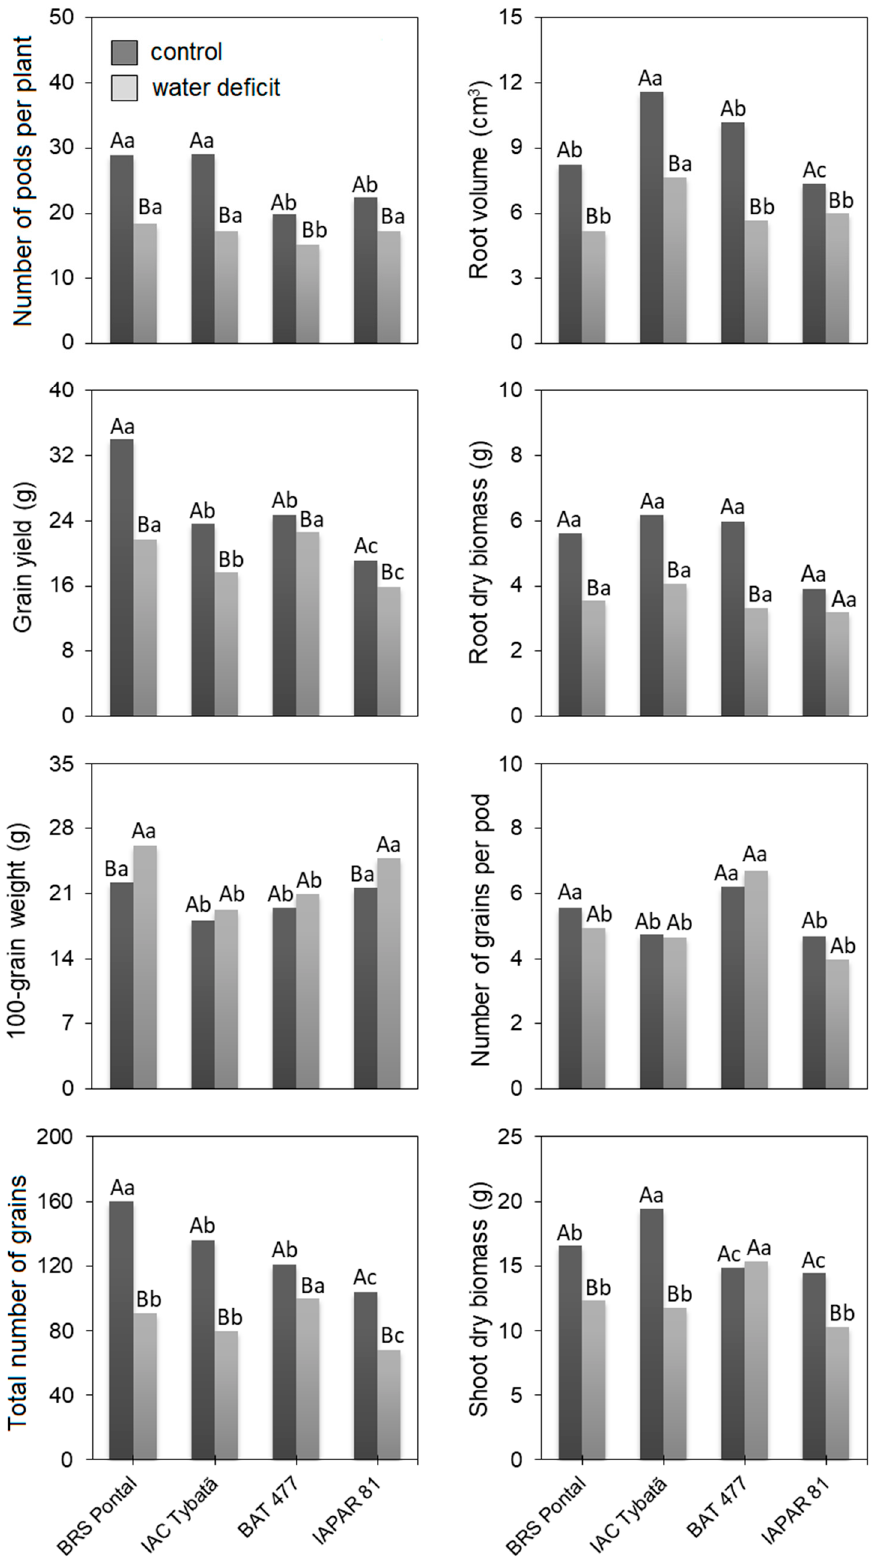
Figure 1. Means of morphoagronomic traits of common bean cultivars evaluated under control and water-deficit conditions. Uppercase and lowercase letters refer to comparisons by the Scott–Knott test ( p < 0.05) between water regimes and cultivars, respectively.